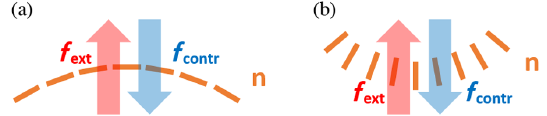
FIG. 1. Bend (a) and splay (b) perturbations of the director field n cause active forces which set up active flows which further enhance or stabilize the respective perturbation. Forces in extensile or contractile systems are denoted by red or blue arrows, respectively. It is apparent that extensile (contractile) systems are unstable to bend (splay)